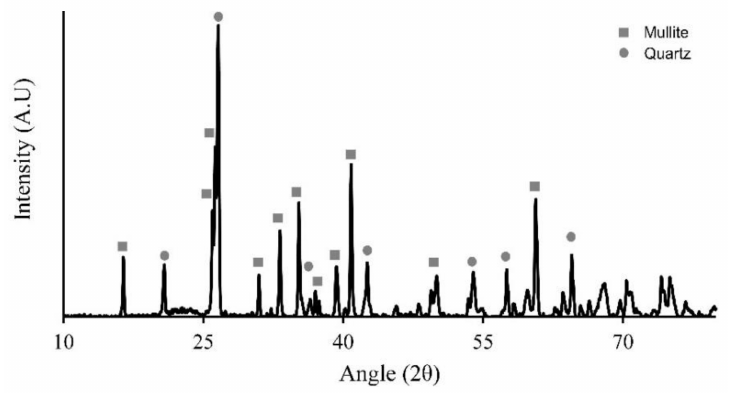
Figure 5. XRD spectra of fly ash (FA)